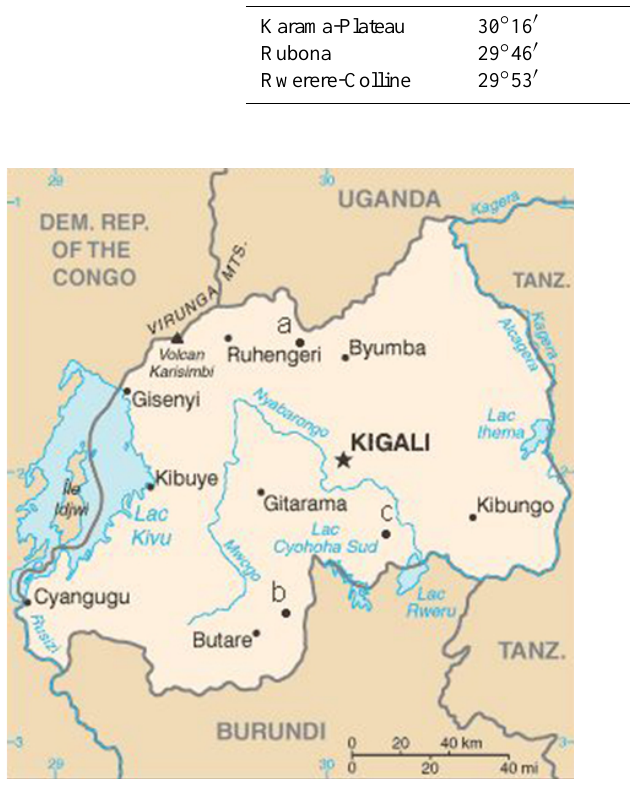
Fig. 1. Map of the Republic of Rwanda with the location of the stations, Rwerere-Colline (a) , Rubona (b) and Karama-Plateau (c)